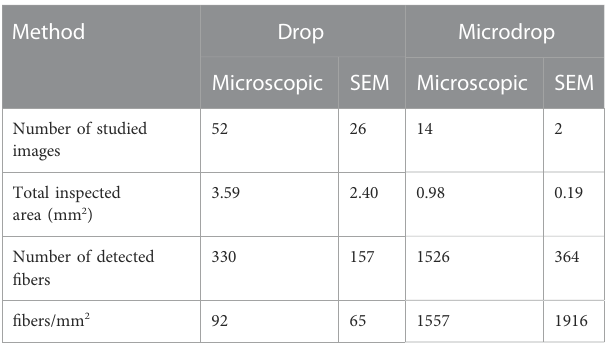
TABLE 3 Manual counting of asbestos fi bres in optical and SEM images collected on samples deposited with the drop and micro-drop methods, respectively.